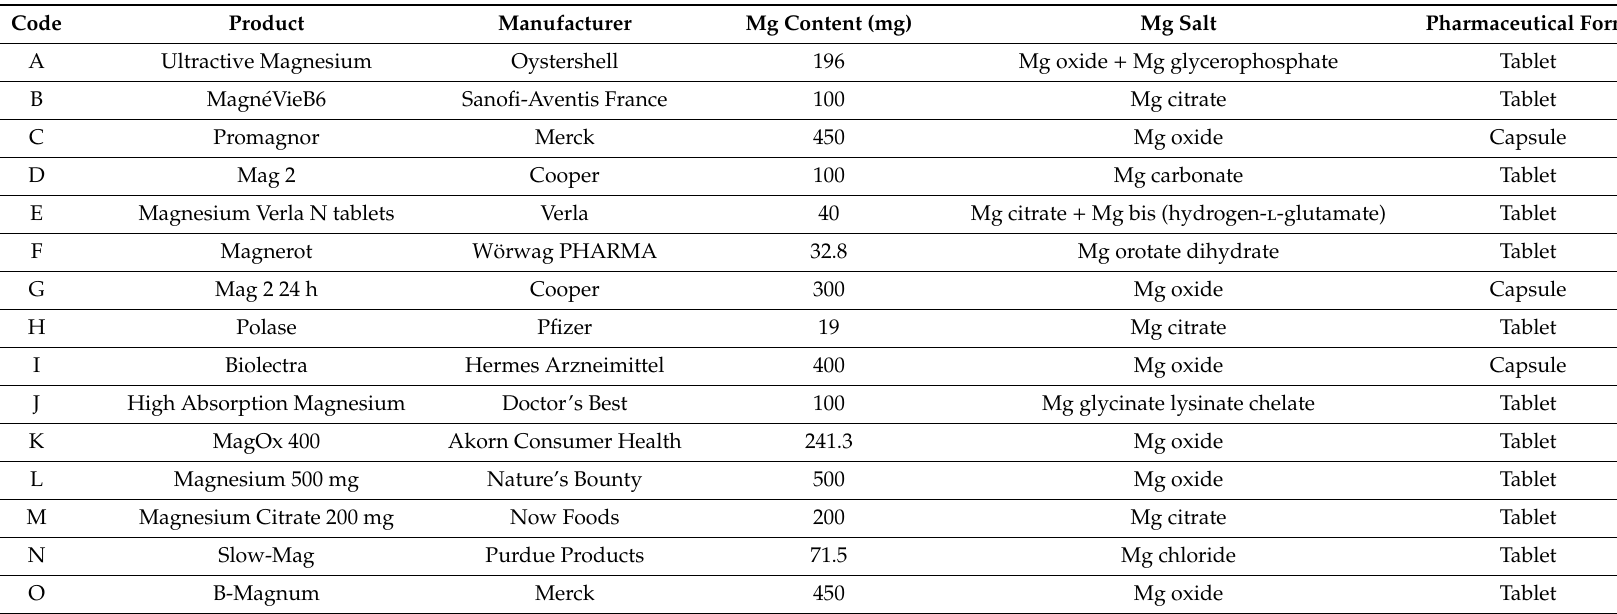
Table 1. Overview of the 15 magnesium formulations used for the in vitro Simulator of the Human Intestinal Microbial Ecosystem (SHIME) and dissolution